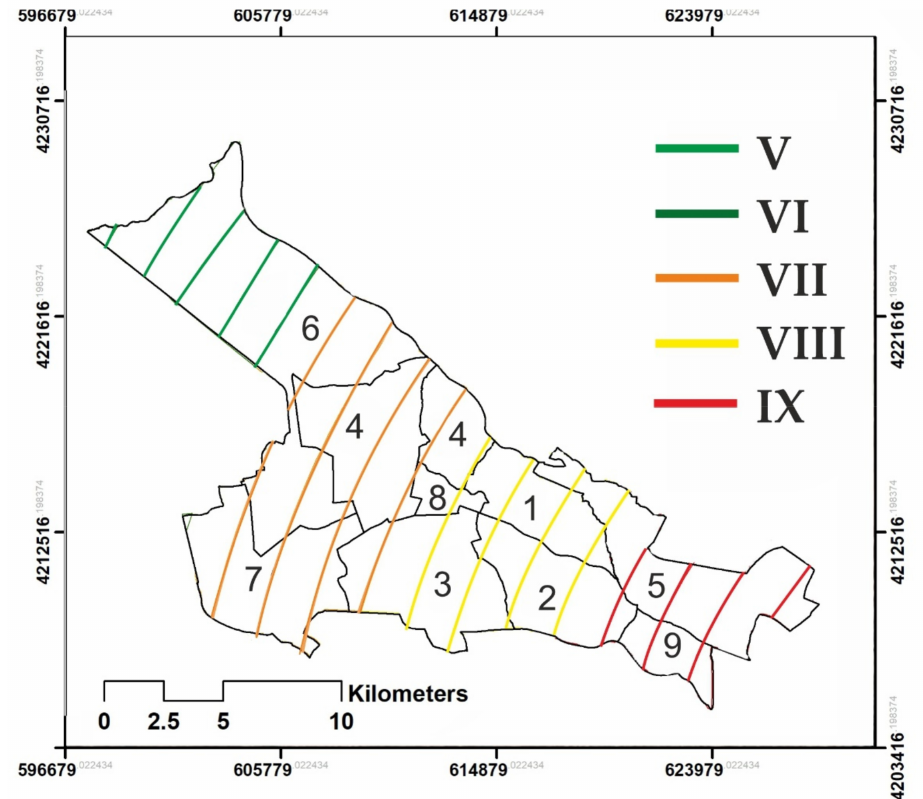
Figure 8. Intensity map of a 7.4 (1780) magnitude earthquake (the Roman numerals represent the Modified Mercalli